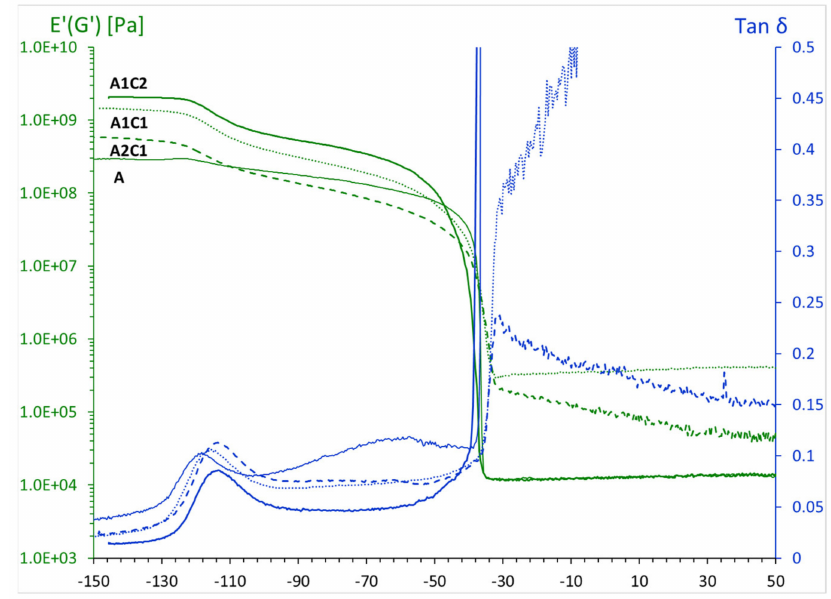
Figure 10. DMA characterization of reference sample A and AxCy series.